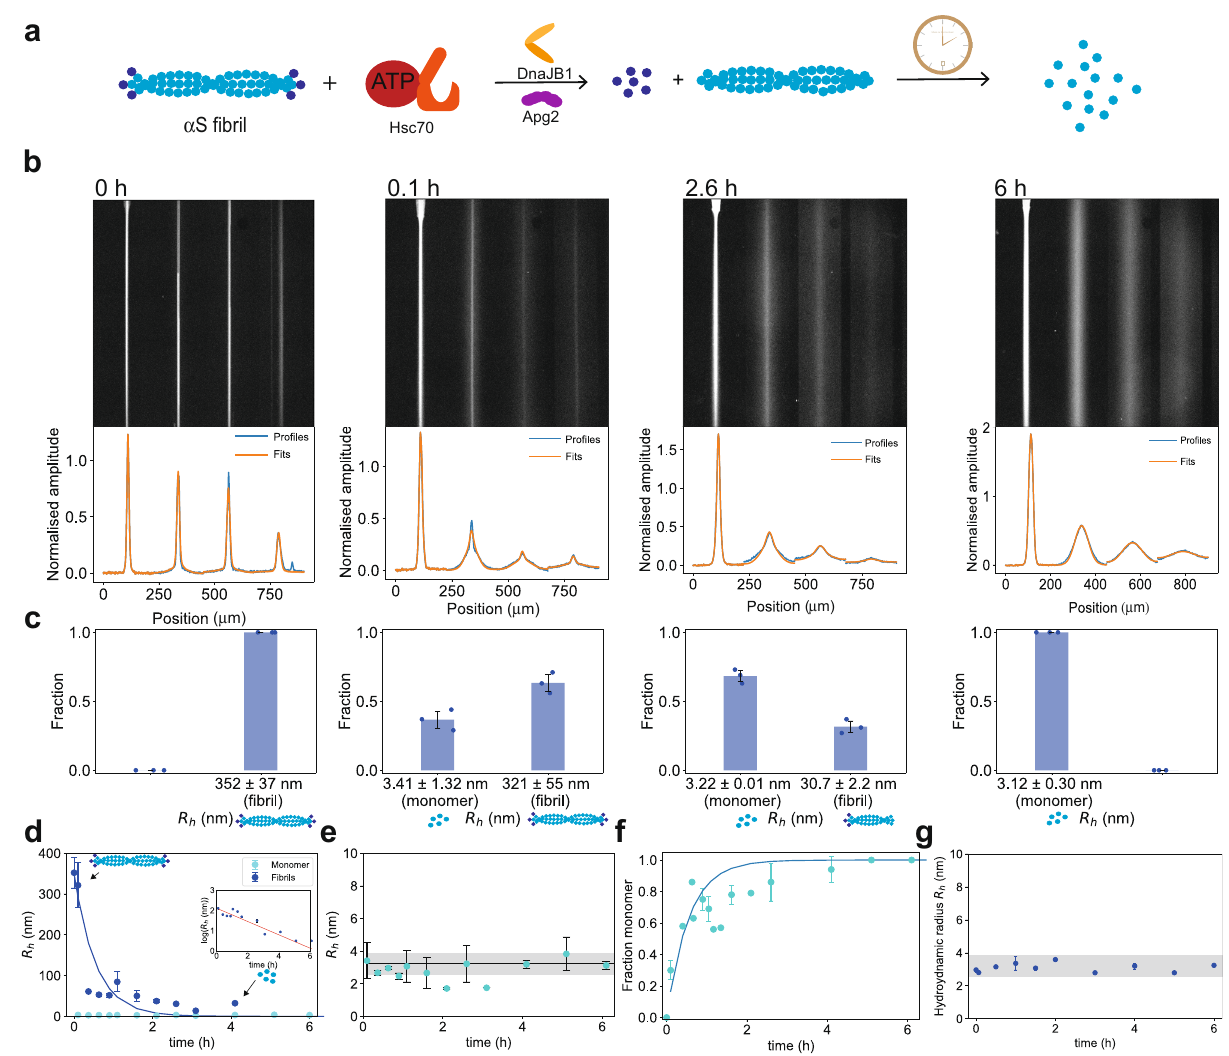
Fig. 2 Diffusional sizing and kinetic analysis of α S fi bril disaggregation by the Hsc70 chaperone machinery. a Schematic of the disaggregation reaction and the experimental assay. b Representative images of micro fl uidic diffusional sizing experiments at different time points and diffusion pro fi les obtained from image analysis during the disaggregation time course. The four different channels represent four different diffusion times; the less diffusive spreading there is in these four channels, the larger the molecule is. It can be seen that diffusion pro fi les broaden over time, indicating that a smaller species is created during the disaggregation reaction. At 0.1 h and 2.6 h, the pro fi les show an overlay of two species, one with high diffusivity, one with little diffusivity, indicating a heterogeneous population of a small, broadly diffused-out species and a larger, little diffusing species was observed, while the population was homogeneous at 0 h and 6 h. Extracted R h values for the small and large species from diffusion pro fi le fi tting at these time points are reported in panel b . The experimentally obtained diffusional pro fi les are shown in blue and the obtained fi ts in orange. c Histograms showing the size distribution of the two species from image analysis. At 0 h and 6 h, R h values of single-component fi ts are reported. The individual data points are overlayed on the bar plot. d Evolution of R h for small (cyan) and large species (blue) over time. The size of the larger species decayed monotonically, consistent with a single exponential fi t (blue line). The size of the smaller species remained constant over time. Inset: logarithmic representation of R h,large over time. From these fi ts, a rate constant of k = 1.8 ± 0.3 × 10 – 4 s – 1 was determined ( R 2 = 0.89). e R h of the small species compared to R h of pure monomer (black line and grey region indicate the expected size and size range from pure monomer). This analysis shows that monomer is produced throughout the reaction and no other intermediate is generated. f Fraction of monomer over time (cyan), showing that the fraction of monomer increases over time, whereby less monomer is generated at later time points, consistent with Fig. 2d. ( R 2 = 0.89). g Time course experiment. 100 nM α S monomers labelled with Alexa Fluor 488 are added to a disaggregation mixture with 2 μ M unlabelled α S fi brils, and the size of the fl uorescent species is measured over time. The size remains largely constant over the time course of the 6 h experiment, showing the inhibition of elongation through the disaggregation machinery. Data in c – g are represented as mean ± standard deviation of n = 3 independent diffusion pro fi les of protein molecules, here α S species, fl owing in products. The diffusional sizing approach overcomes this pro- a micro fl uidic channel (Fig. 2a). The diffusion pro fi les are then analysed by considering advection – diffusion processes to extract the distribution of diffusion coef fi cients (not shape-dependent) and the corresponding hydrodynamic radii ( R h ) of the individual species present in solution 40,42 . The diffusion coef fi cient is, process in both space and time by acquiring the longitudinal